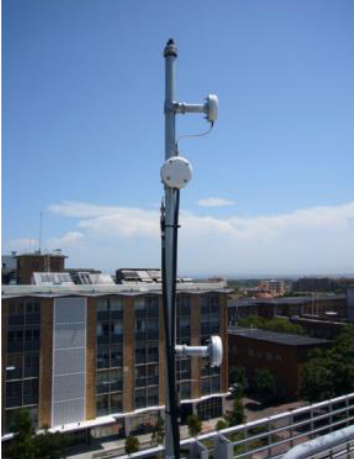
Figure 2. Typical LocataLite setup [29].